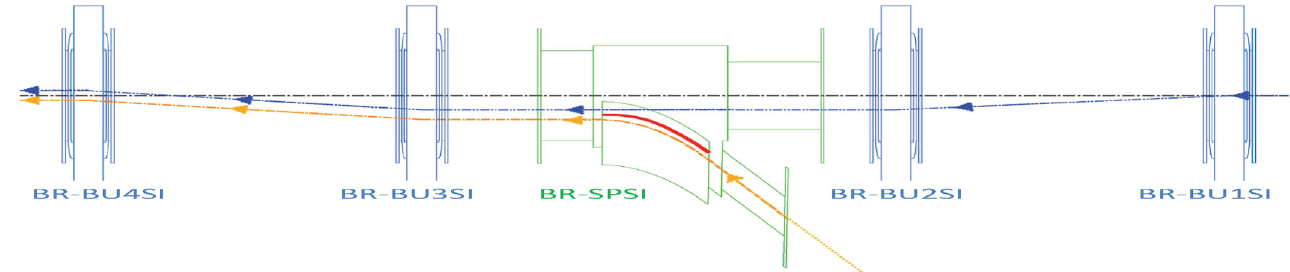
FIG. 7. Schematic of the booster injection straight showing the injection of the second bunch train. The blue magnets are the injection kickers, the green magnet is the septum.